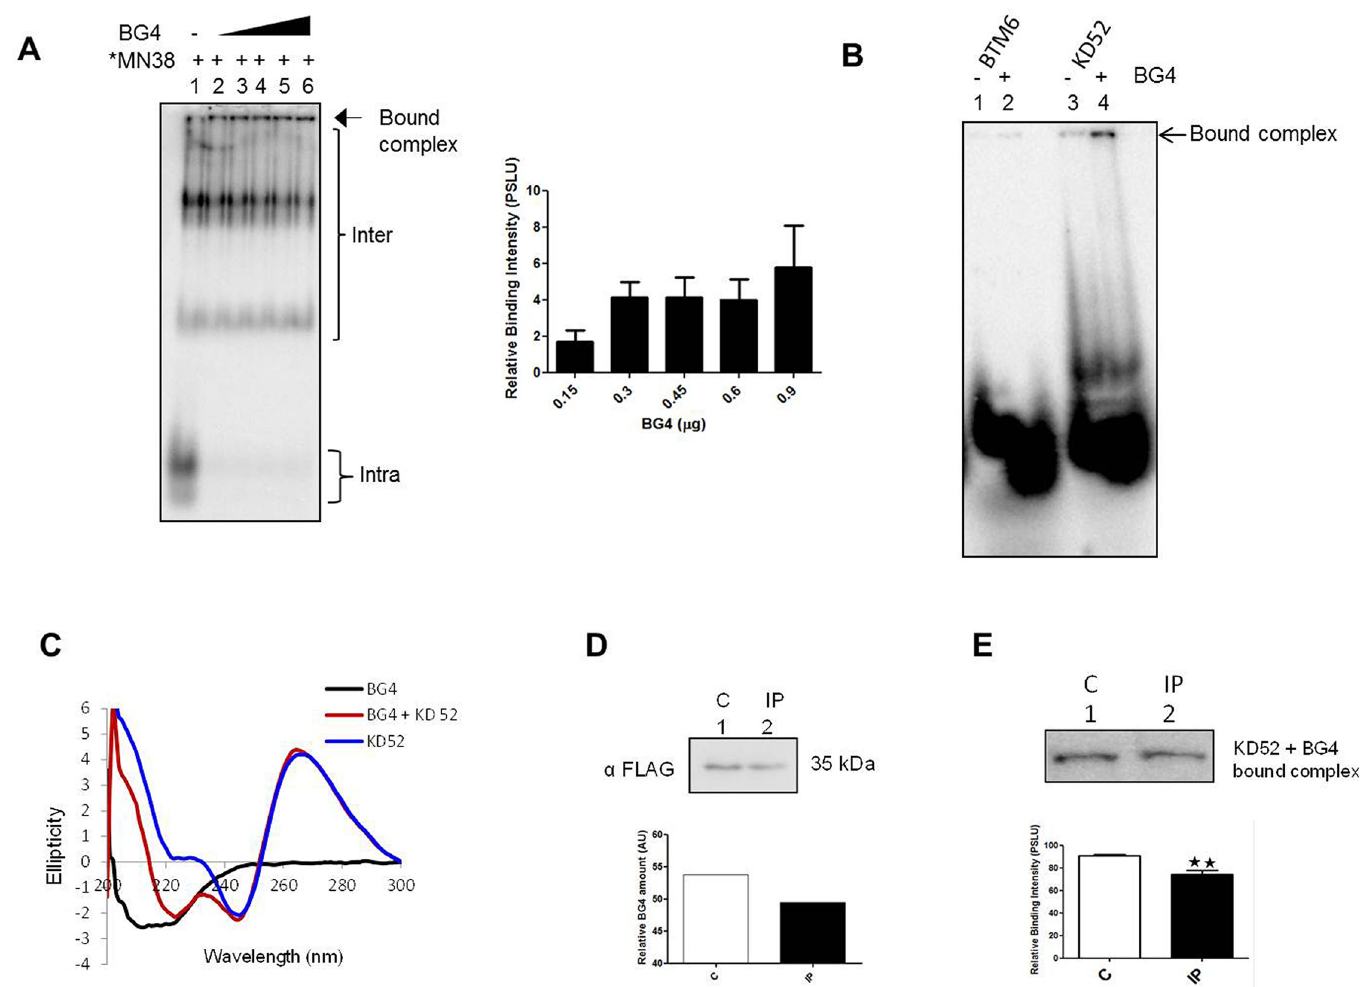
Fig 9. Evaluation of BG4 binding to G-quartets with GNGs as a structural component. (A) Binding of MN38 to increasing concentrations of BG4 (0.15, 0.3, 0.45, 0.6 and 0.9 μ g; Lanes2-6) in presence of KCl (100 mM). (B) Binding of KD52 (G-quadruplex forming SHOX sequence) and a scrambled DNA control, BTM6 to BG4 (0.45 0078g) in presence of 100 mM KCl. (C) CD spectra of FLAG-tagged BG4 (5 μ g) and its ability to bind KD52. (D) Immunoblot for BG4 (control and after IP) using anti-FLAG antibody. Quantification depicts relative reduction in BG4 level after IP. (E) Binding of BG4 to KD52. Upper panel depicts a representative gel image (6% native PAGE) for the relative binding of BG4 (between control and IP reaction) to KD52. Quantification based on multiple repeats is also